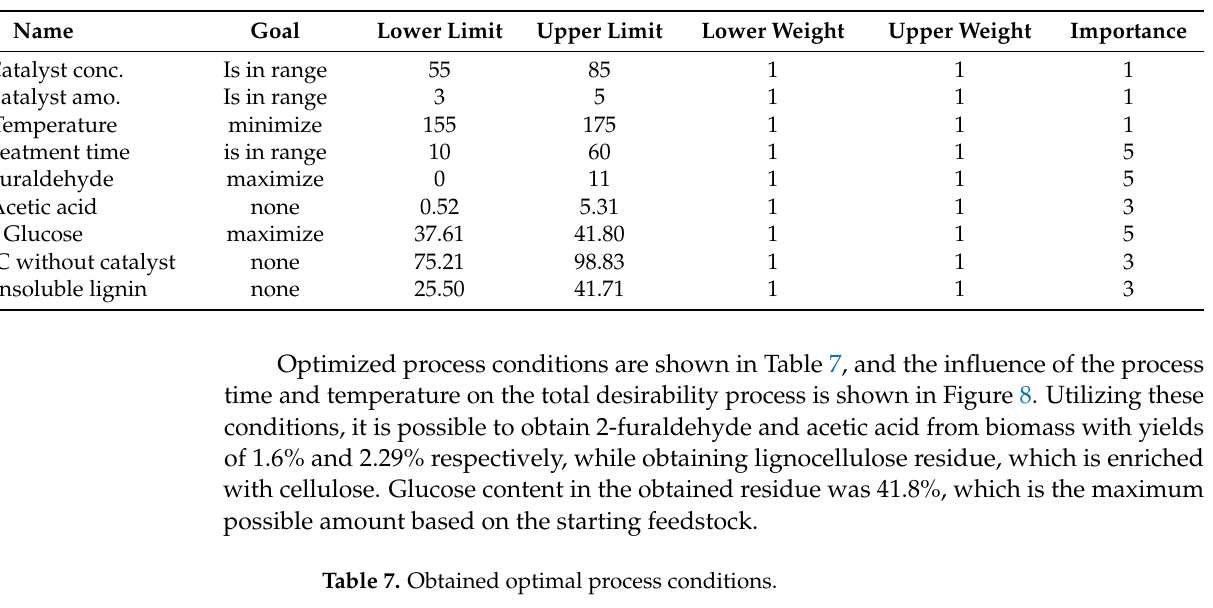
Table 6. Set parameters and their limits for experimental model optimization.